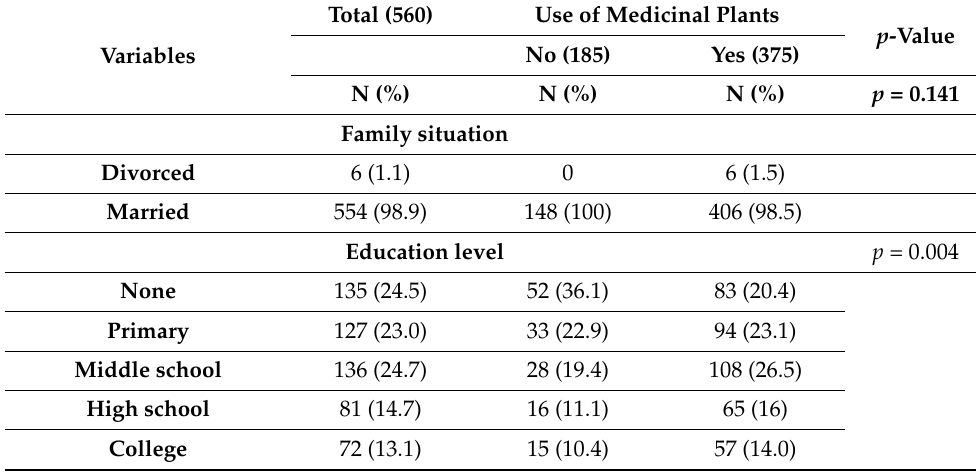
Table 2. Socio-demographic characteristics of pregnant and postpartum women who participated in the